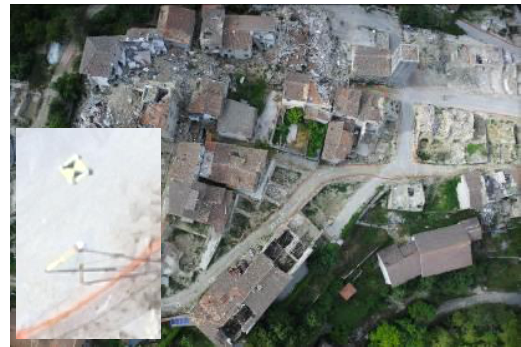
Figure 4. Example of raw image and related level of detail (bottom left, artificial 0.4 x 0. 4 m 2 marker and GNSS receiving station mounted on a